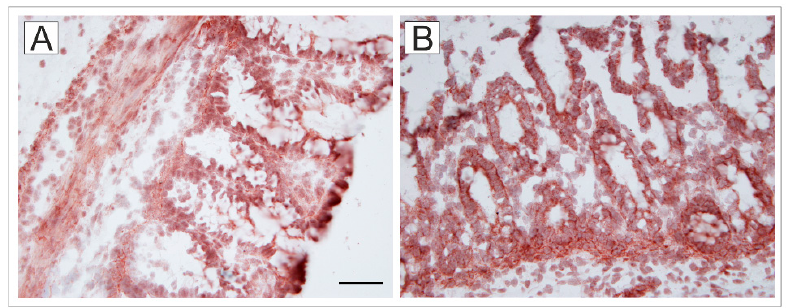
Figure 6. Expression of HMGB1 in the colon. Representative micrographs of the germ-free (GF; ( A )) and S . Typhimurium LT2-infected piglets for 24 h (LT2; ( B )) are depicted. The scale bar ( A ) corresponds to 50 μ m.